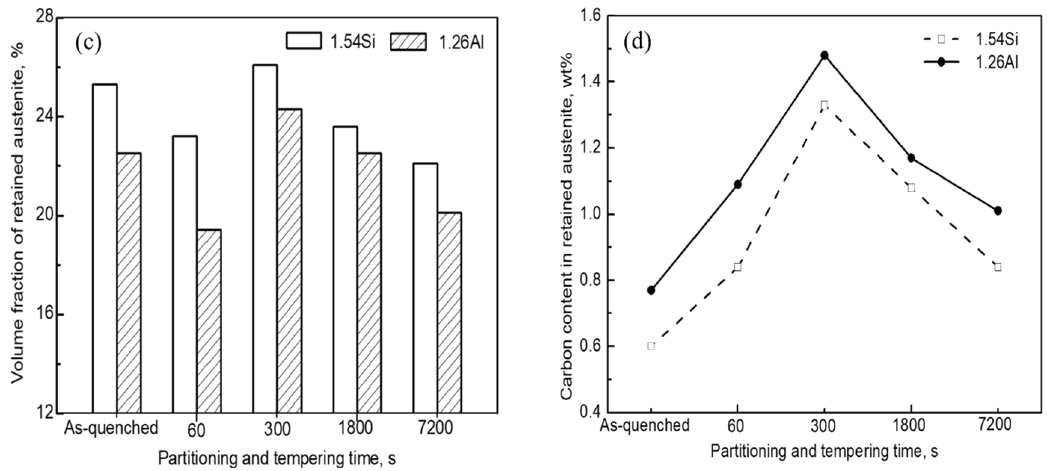
Figure 3. XRD results for the specimens with Q–P–T (Quenching–Partitioning–Tempering) treatment: ( a ) XRD pattern for the 1.54Si steel; ( b ) XRD pattern for the 1.26Al steel; ( c ) the volume fraction of RA (Retained Austenite) in different specimens; ( d ) the carbon content of RA in different specimens.